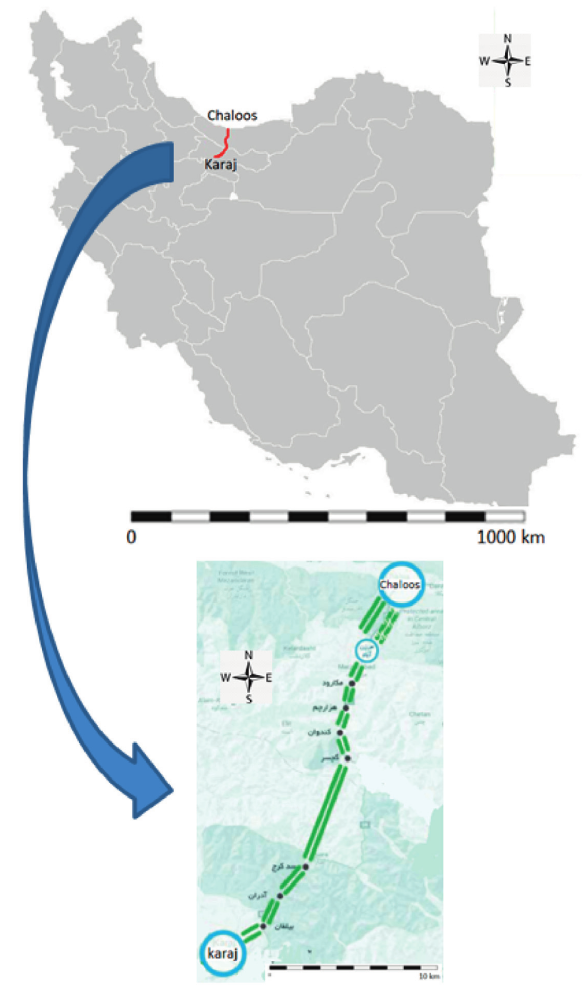
Figure 1: Map of Karaj-Chalus road in